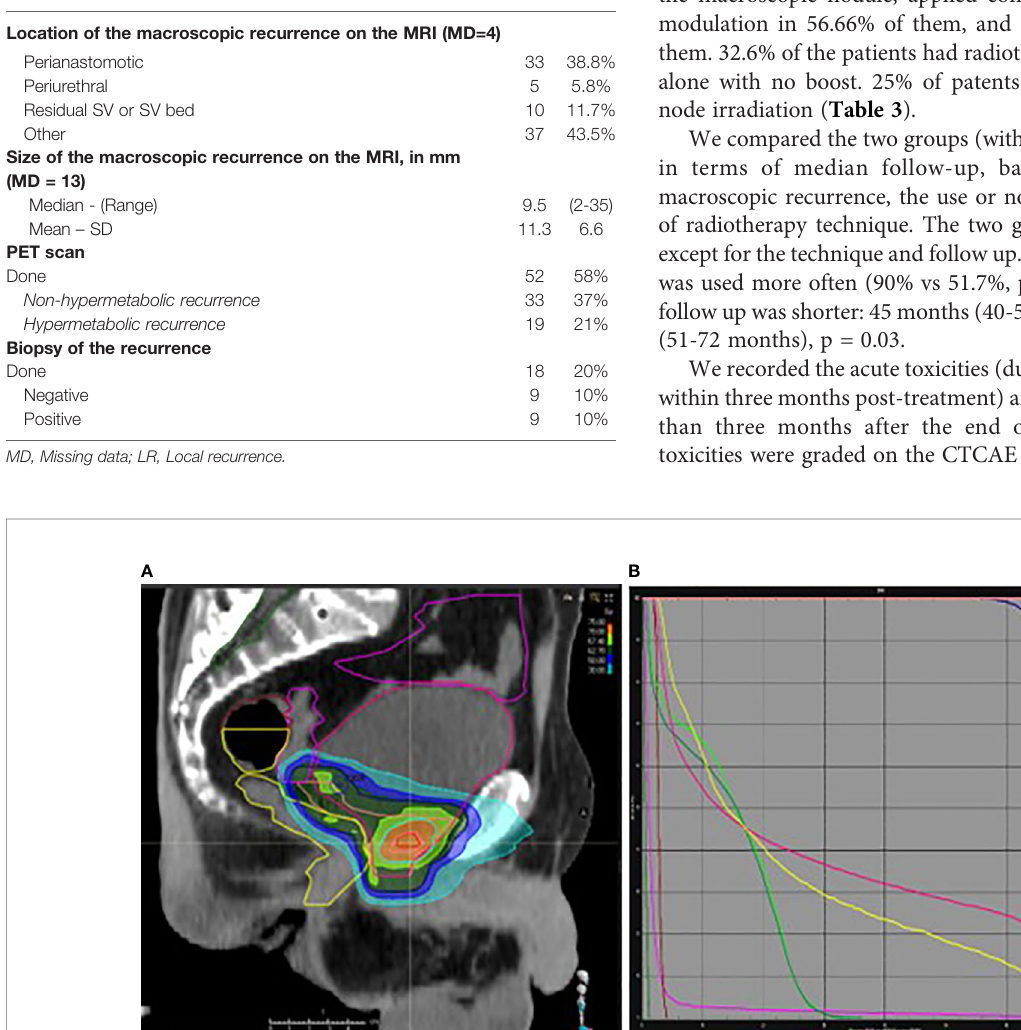
TABLE 2 | Characteristics of the macroscopic recurrence following radical prostatectomy. Characteristics